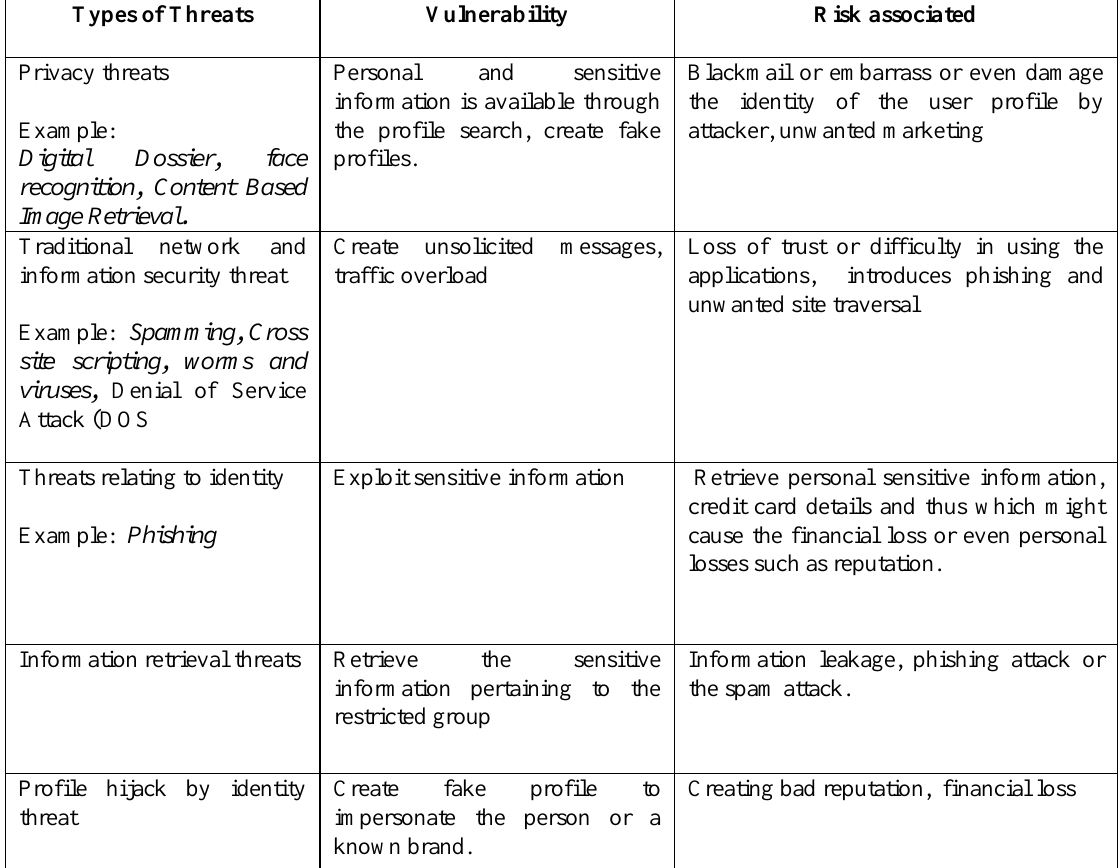
Table 1. Threats and Vulnerabilities of Online Social